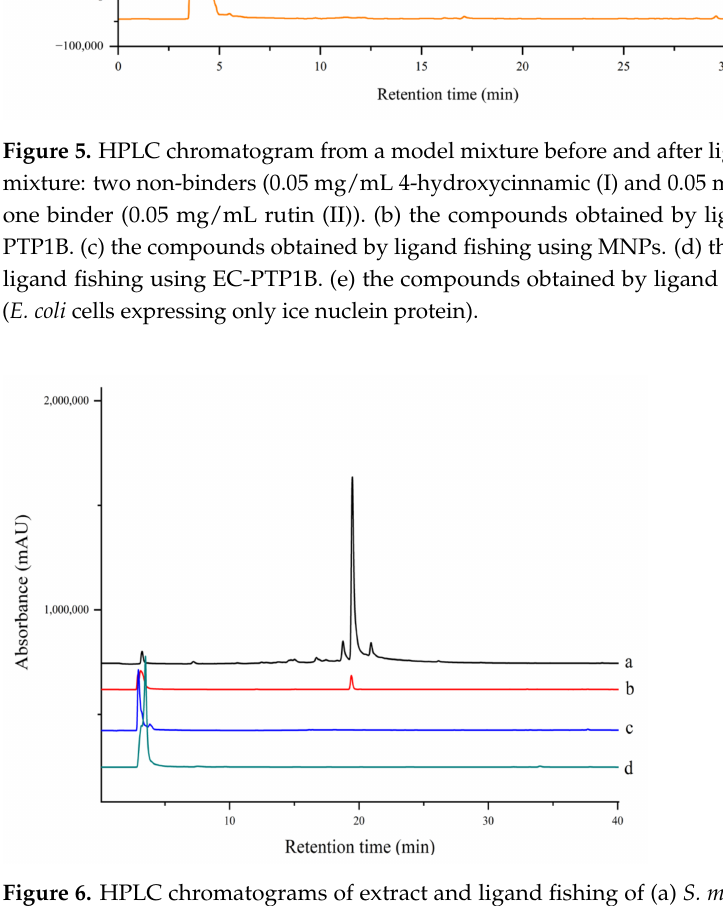
Figure 6. HPLC chromatograms of extract and ligand fishing of (a) S. miltiorrhiza aqueous extract, (b) ligand fishing by EC- PTP1B, (c) ligand fishing by the control cells ( E. coli cells expressing only ice nuclein protein), and (d) ligand fishing by